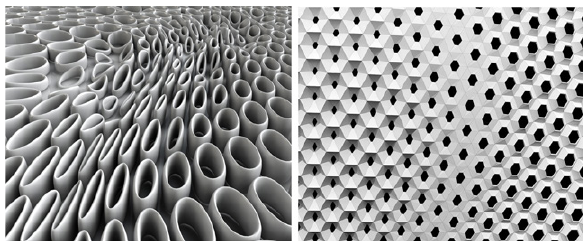
Figure 3. Design elements created using parametric design with similar spatial properties to the natural images